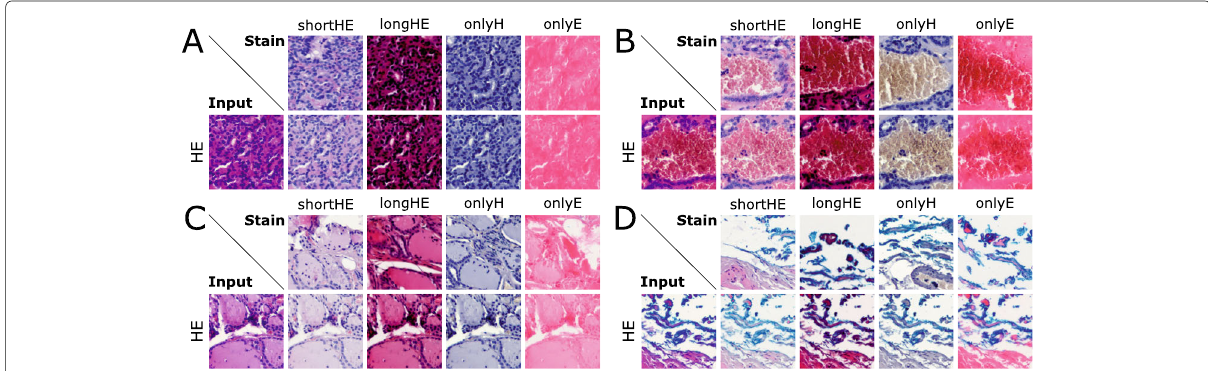
→ X fake . Here, the input image is from domain A of the A B